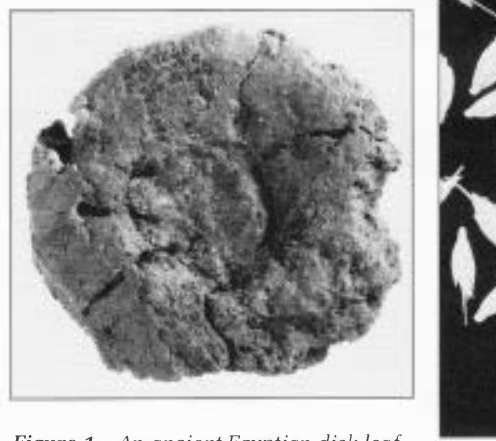
Figure 1 An ancient Egyptian disk loaf (maximum diameter 14 cm) of the Ninth Figure 2 Threshed hulled wheat (left) and free-threshing wheat (right). The threshed hulled wheat ear falls apart into spikelets whereas the chaff of free-threshing wheat falls Dynasty (c. 1500 BC}, now at the Ashmolean cleanly away from the Museum, Oxford (museum no. 1921.1395).